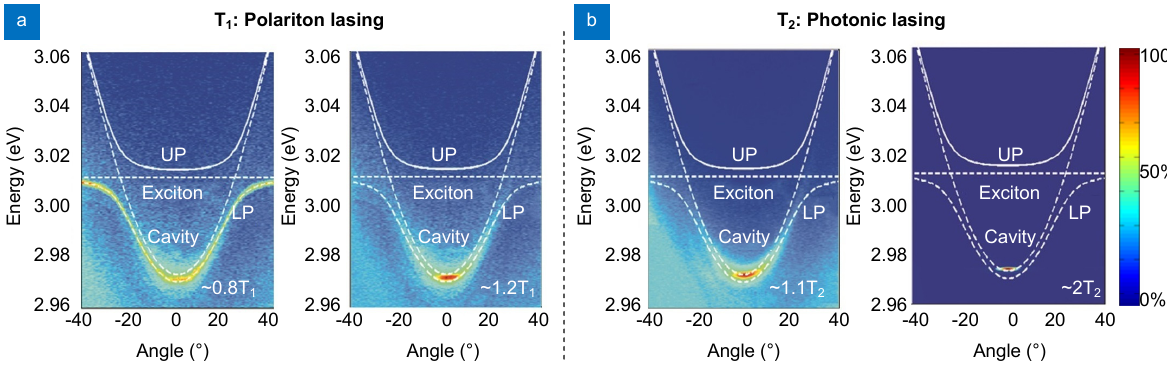
Fig. 4 | The k-space mapping of exciton polaritons under different excitation power. (a) and (b) polariton (T 1 ) and photonic (T 2 ) lasing thresholds